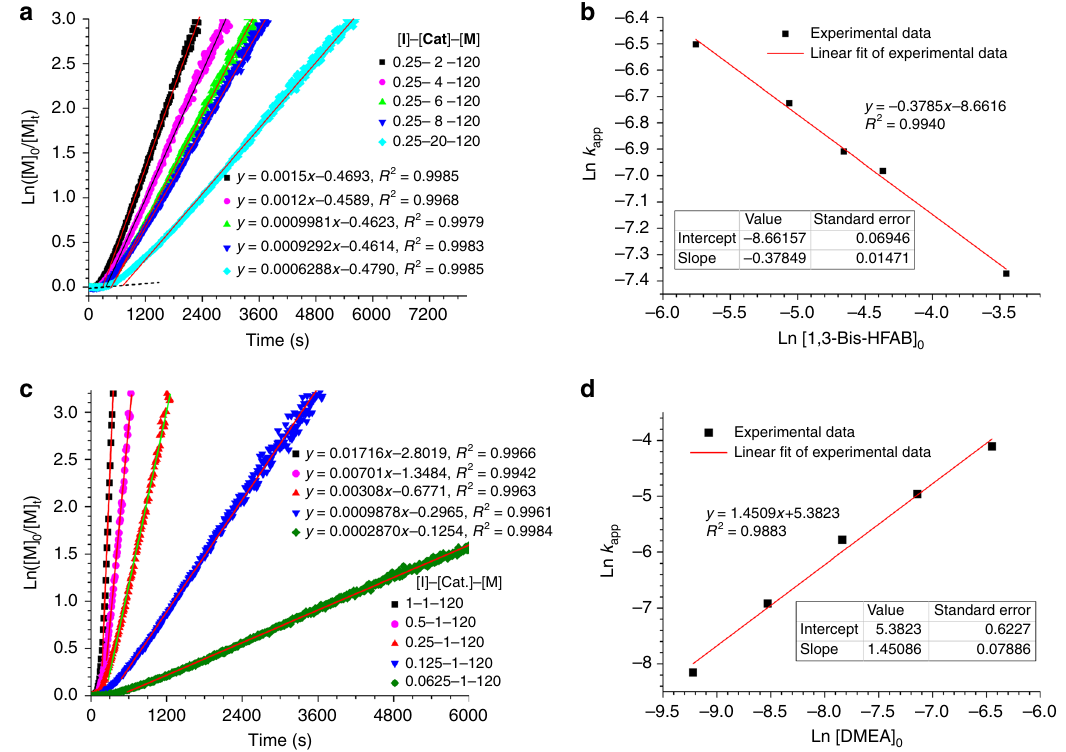
Fig. 4 Kinetics study of Glu-NCA polymerization catalyzed by 1,3-Bis-HFAB at room temperature in CH 2 Cl 2 . a , b [1,3-Bis-HFAB] 0 = 1.7 – 17 mol% vs. [Glu-NCA] 0 , [DMEA] 0 = 4 × 10 − 4 M and [Glu-NCA] 0 = 0.19 M; c , d [1,3-Bis-HFAB] 0 = 1.58 × 10 − 3 M, [DMEA] 0 = 0.05 – 0.8 mol% vs. [Glu-NCA] 0 and [Glu-NCA] 0 = 0.19 M. (Source data are provided as a Source Data fi